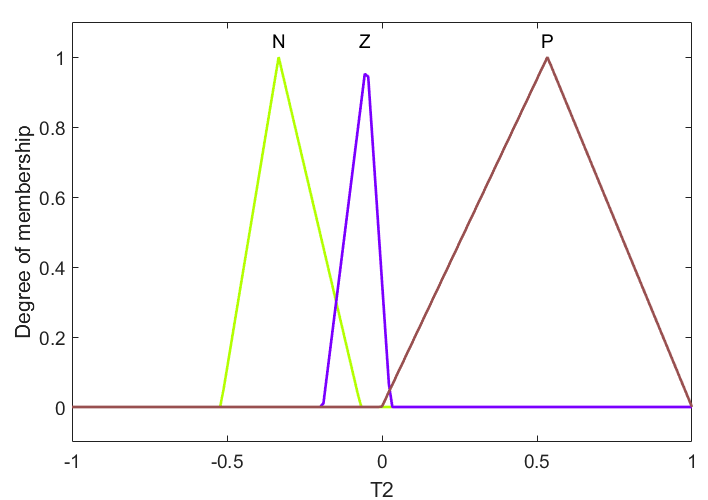
Figure 20. Output 1 optimized by DSO.